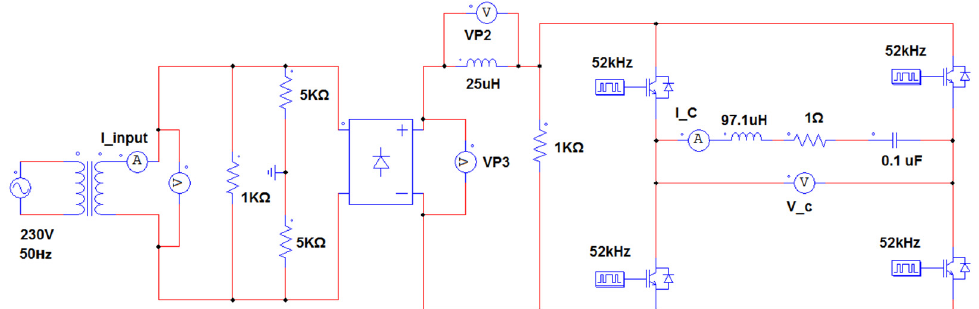
Figure 8. Simulation circuit diagram of an IH system without any filter.